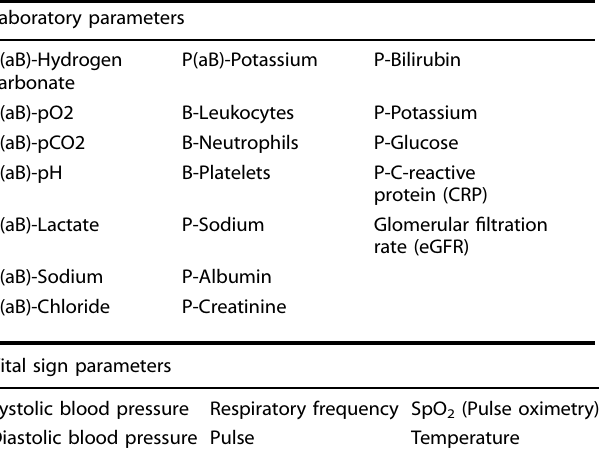
Table 5. List of clinical